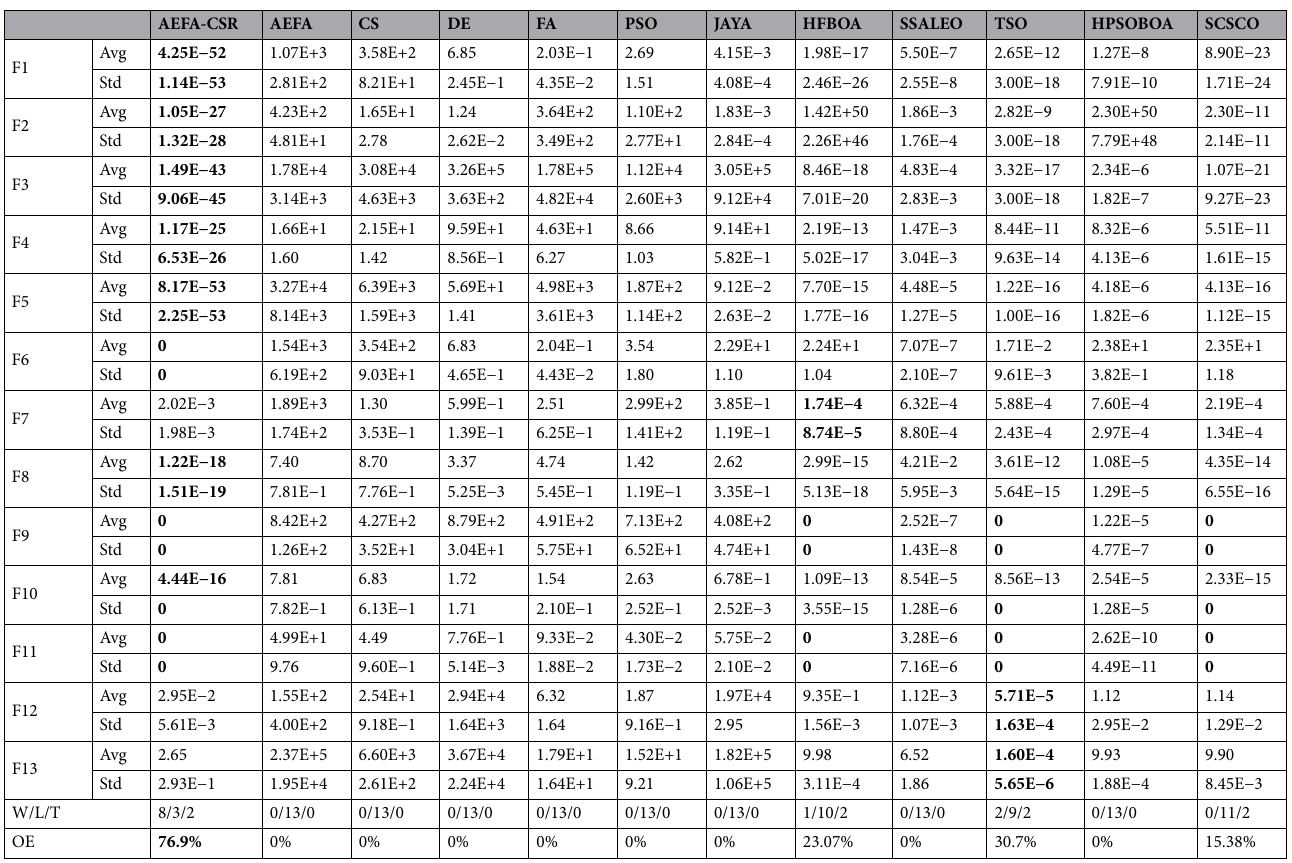
Table 7. F1–F13 comparison with dimension = 100 and population = 30 . Significant values are in